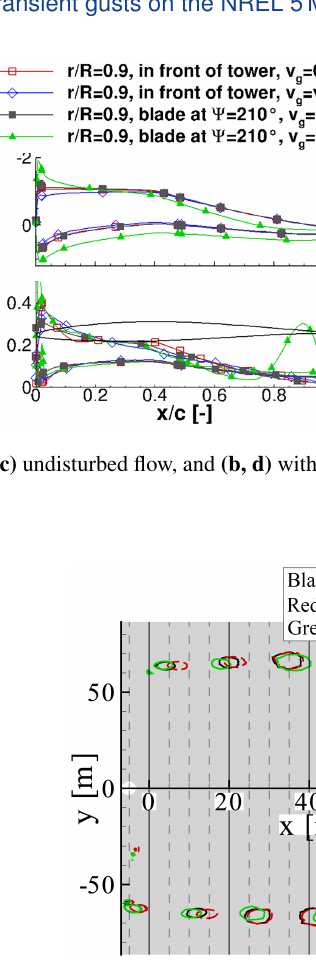
Figure 11. Tip vortex transportation in the vertical plane through the rotor